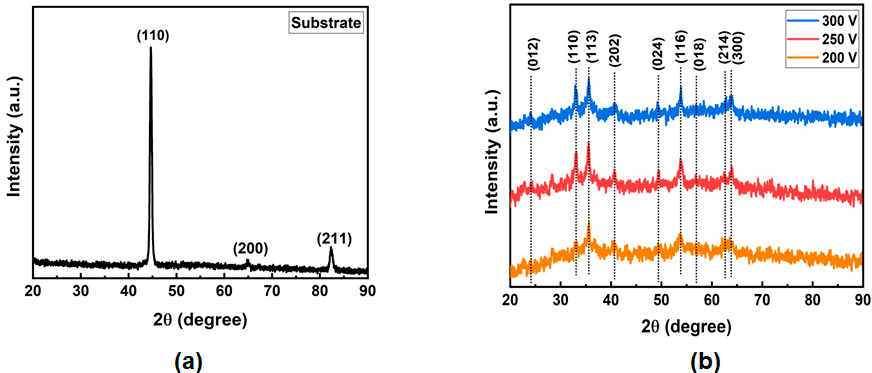
Figure 4. XRD patterns for uncoated substrate ( a ) and PEO-treated samples ( b ).